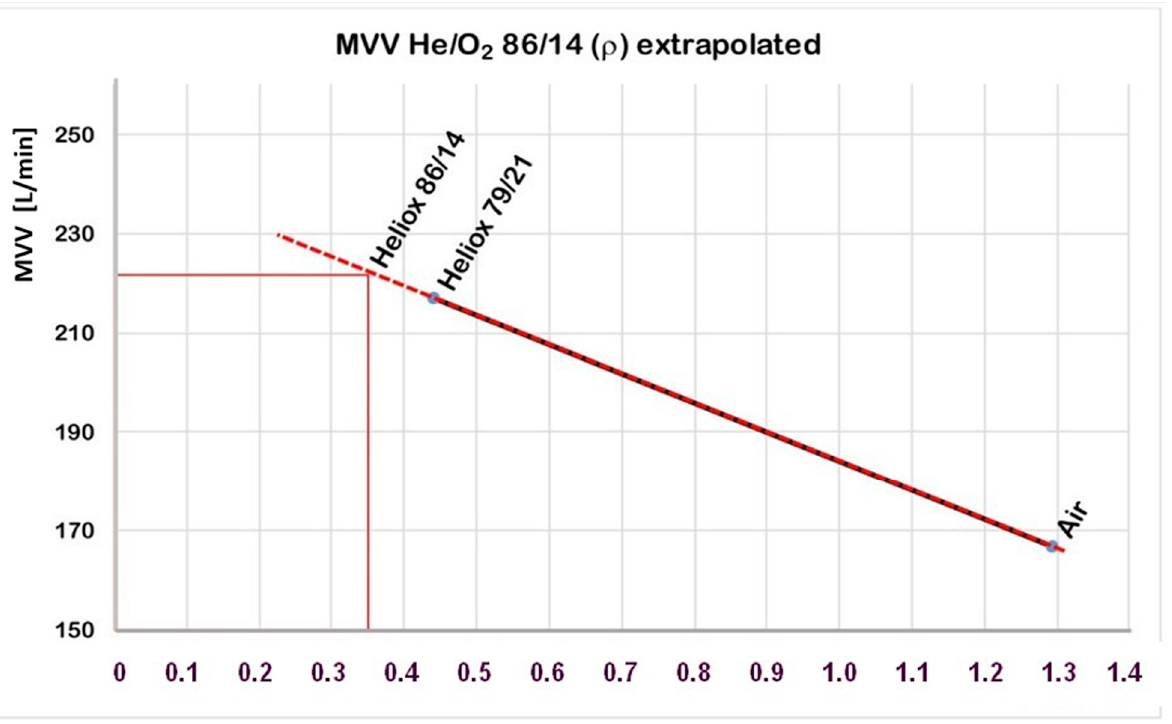
Figure 8. Linear extrapolation of the maximum ventilation volume (MVV) for heliox 86/14 from air and heliox 79/21 values. A surface value of 221 L/min resulted for heliox 86/14. It is accepted that such a MVV results from maximum voluntary hyperventilation.